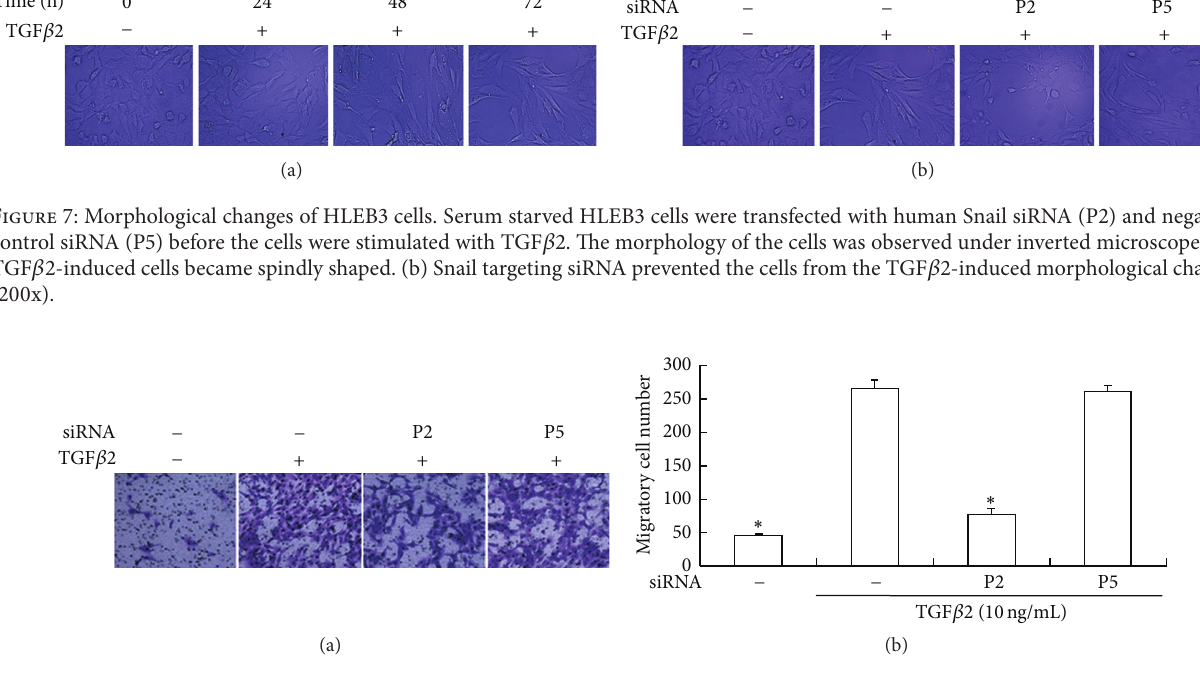
Figure 8: Inhibition of migration ability by Snail siRNA. Serum starved HLEB3 cells were transfected with human Snail siRNA (P2), negative control siRNA (P5) before the cells were stimulated with TGF 𝛽 2 for 48h. Transwell assay was used to detect the migration ability of cells. (a) Crystal violet stained transmembrane cells under light microscope (100x). (b) The count of migrated HLEB3 cells from triplicated experiments. ∗ 𝑃 < 0.05 compared with siRNA ( − )/TGF 𝛽 2 (+)